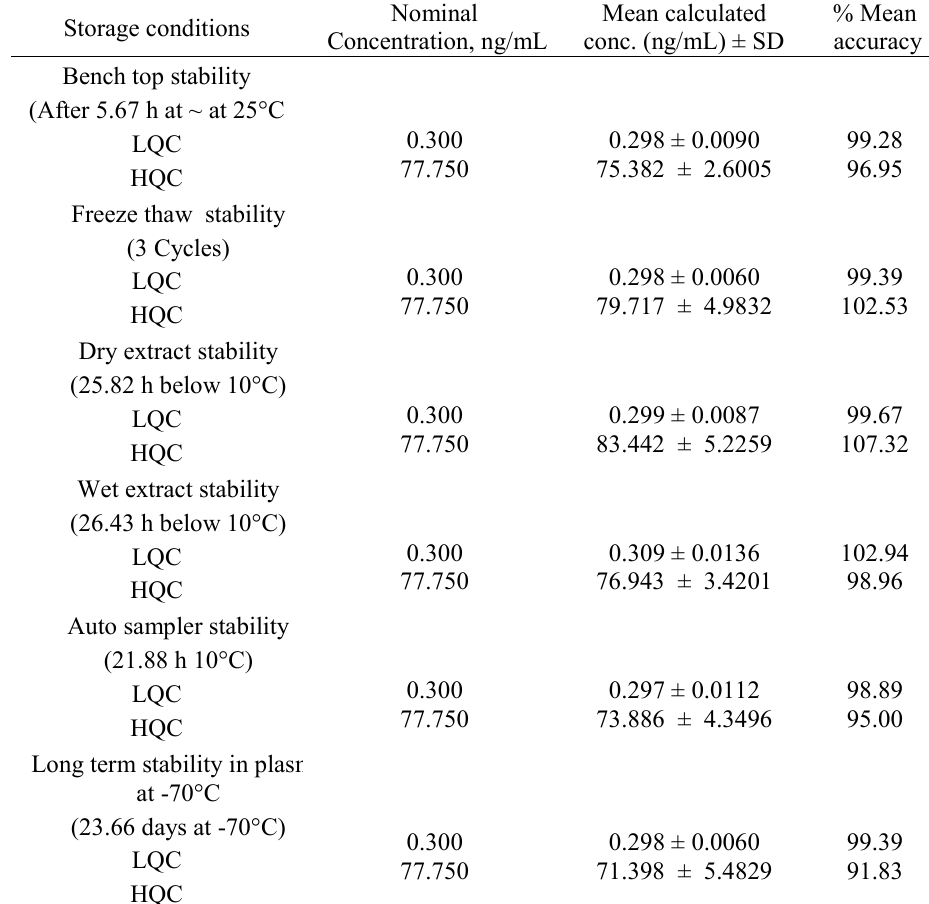
Stock solutions for short term stability of Duloxetine and IS were stable at room temperature for minimum period of about 6 h and between 2 and 8°C for about 7 days. Duloxetine in control human plasma (bench top) at room temperature was stable at least for 5.67 h at ambient temperature and for minimum of three freeze and thaw cycles. Auto sampler stability of the spiked quality control samples maintained at 10°C was maintained up to 21.88 h. Long-term stability of the spiked quality control samples stored at -70°C was determined up to 23.66 days. The accuracy values for different stability experiment in plasma are shown in Table